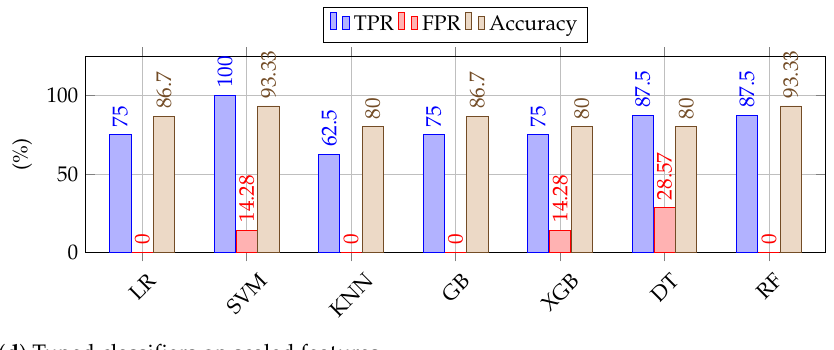
Figure 10. Results of different classifiers (in default settings) on original features ( a ) and scaled features ( c ) and (on best-selected hyperparameters) on original ( b ) and scaled ( d ), respectively. RF as a classifier has outperformed all other contestants: it remained consistent across all experimental settings which prove its effectiveness against all the odds, i.e., (i) the limited number of samples, (ii) high feature variance, and (iii) without parameter